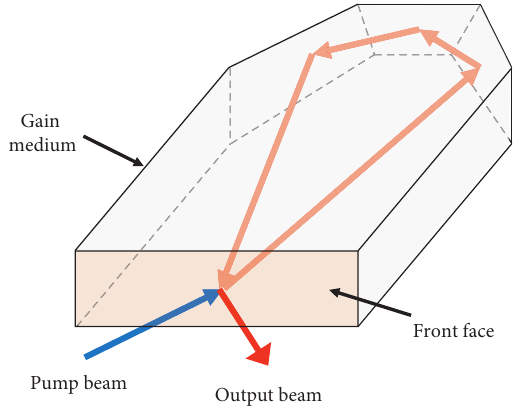
Figure 5: Schematic of an